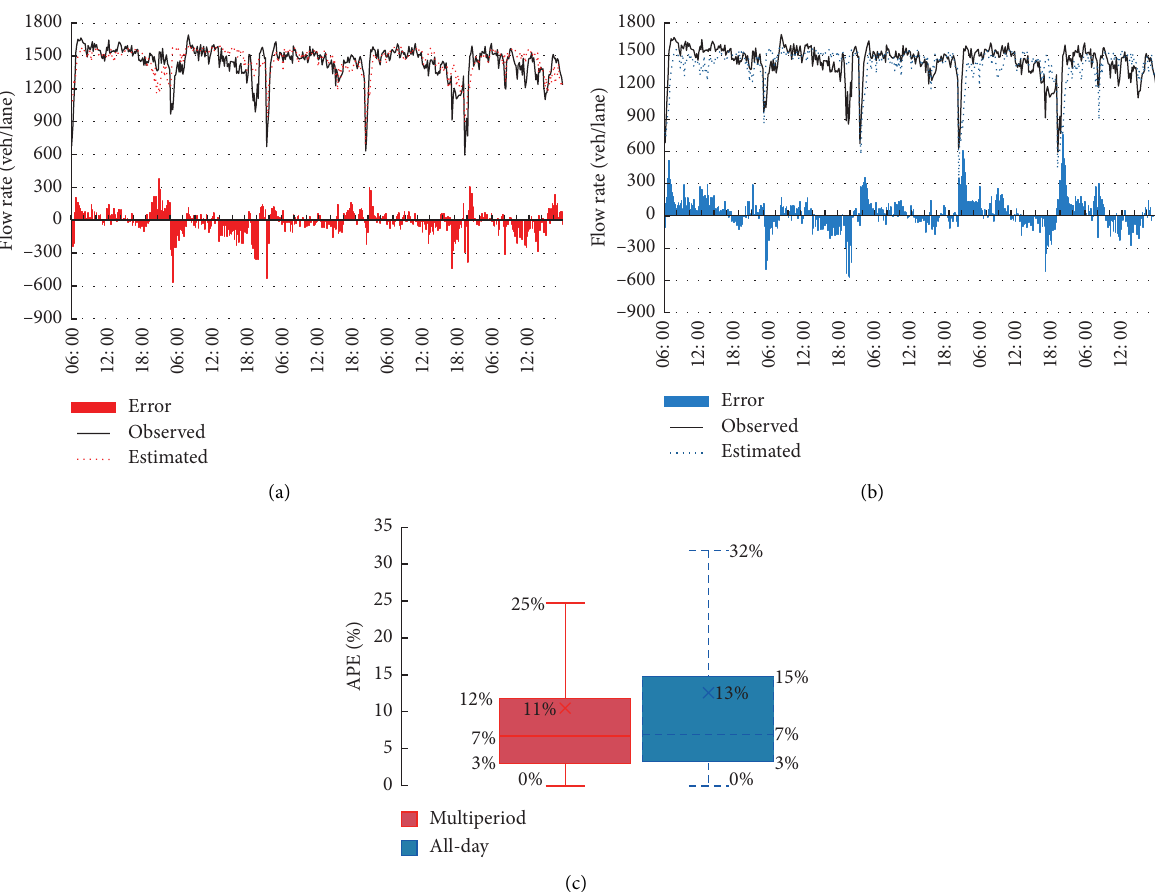
Figure 3: Comparison of observed and estimated flows of different models. (a) Multiperiod model. (b) All-day model. (c) Comparison between the APEs of different models.